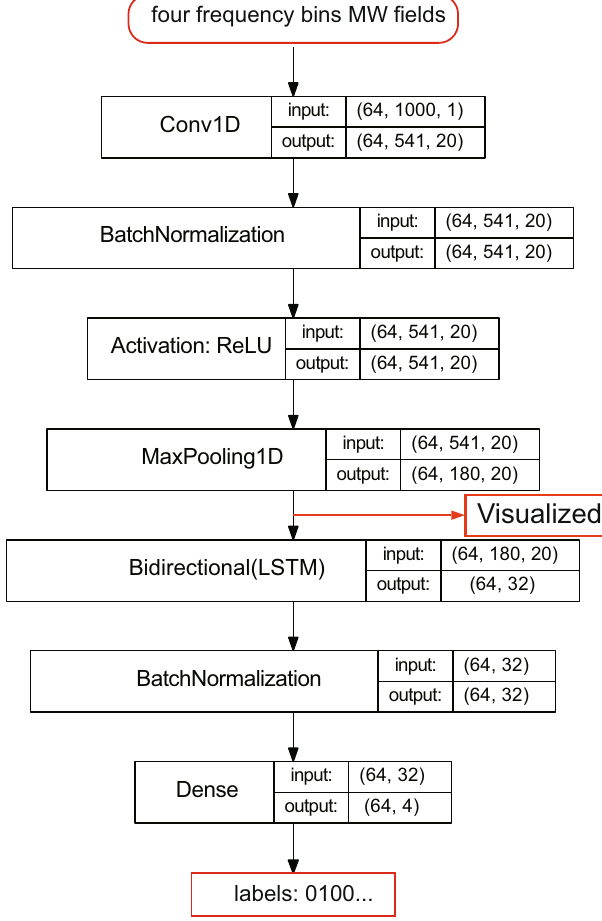
Fig. 7 Structure of our deep learning model and size of the data. The ReLU activation function is f ( x ) = max(0, x ). After the data output from the max-pooling layer, the visualizations are performed; see Supplementary Materials for more